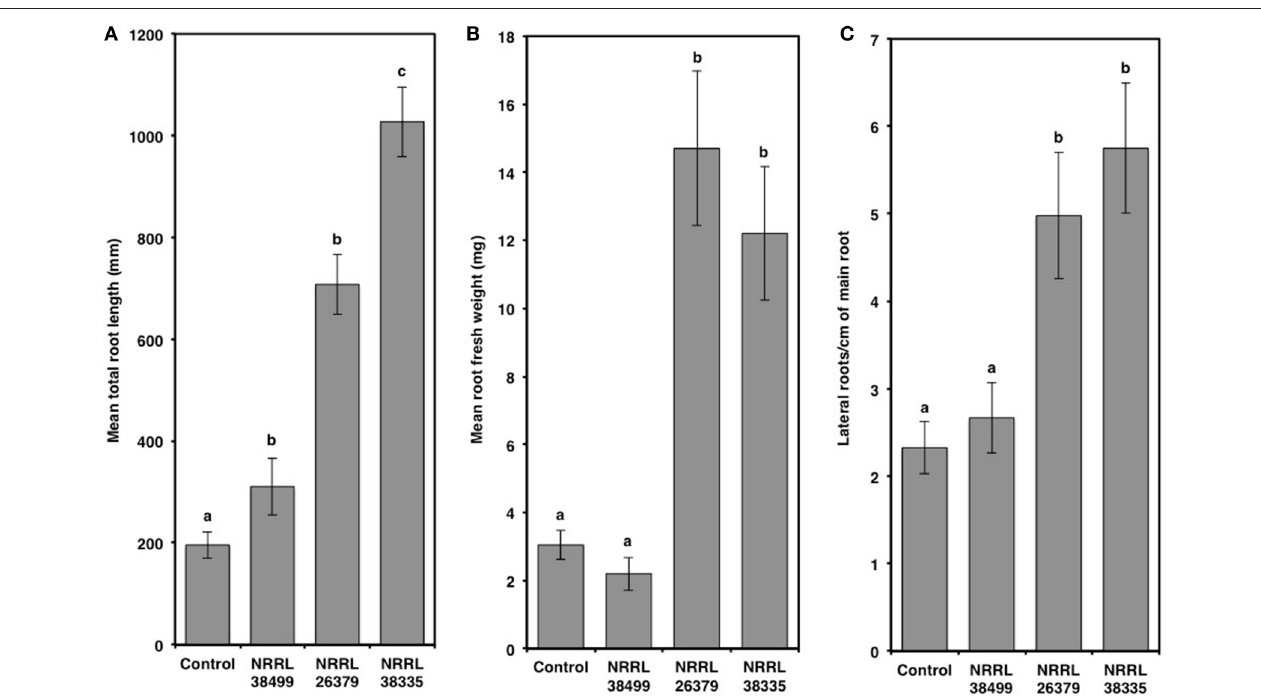
FIGURE 6 | Root alterations caused by F. oxysporum volatiles. (A) total root length, (B) root fresh weight, and (C) lateral root density of Col-0 were quantified after 14 days of cocultivation with no fungus (control), NRRL 38499, NRRL 26379, and NRRL 38335. Means and standard errors for three biological replicates per treatment, with five seedlings per replicate, are shown. Different letters on columns represent statistically significant differences by one-way analysis of variance. Supplementary Figure 6 shows representative roots collected after this experiment.